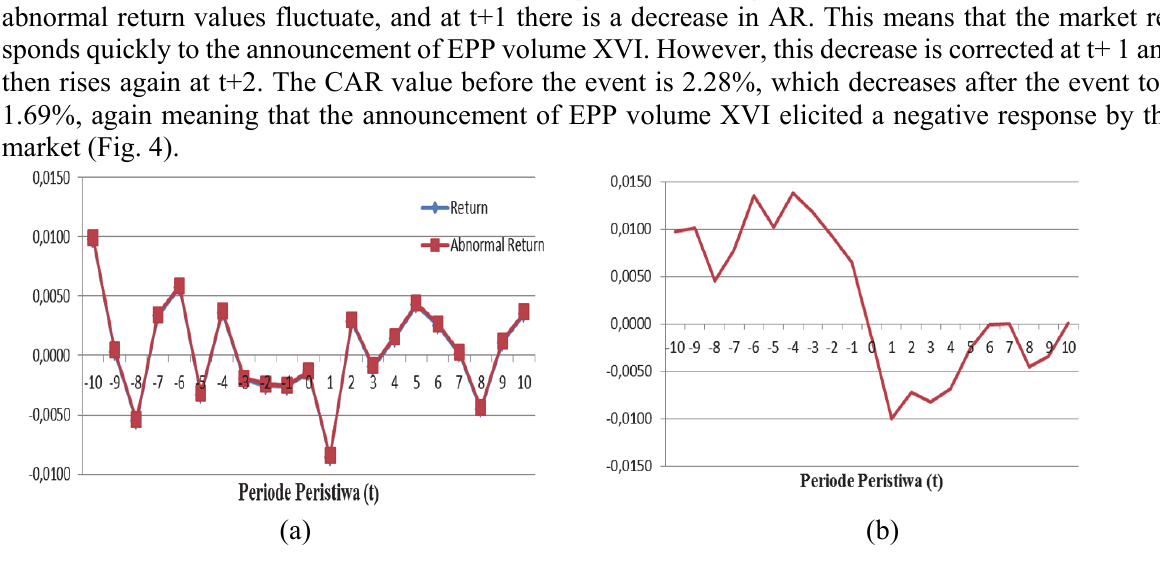
Fig. 4. Movement of (a) Return and Abnormal Return and (b) Cumulative Return on JCI for EPP volume